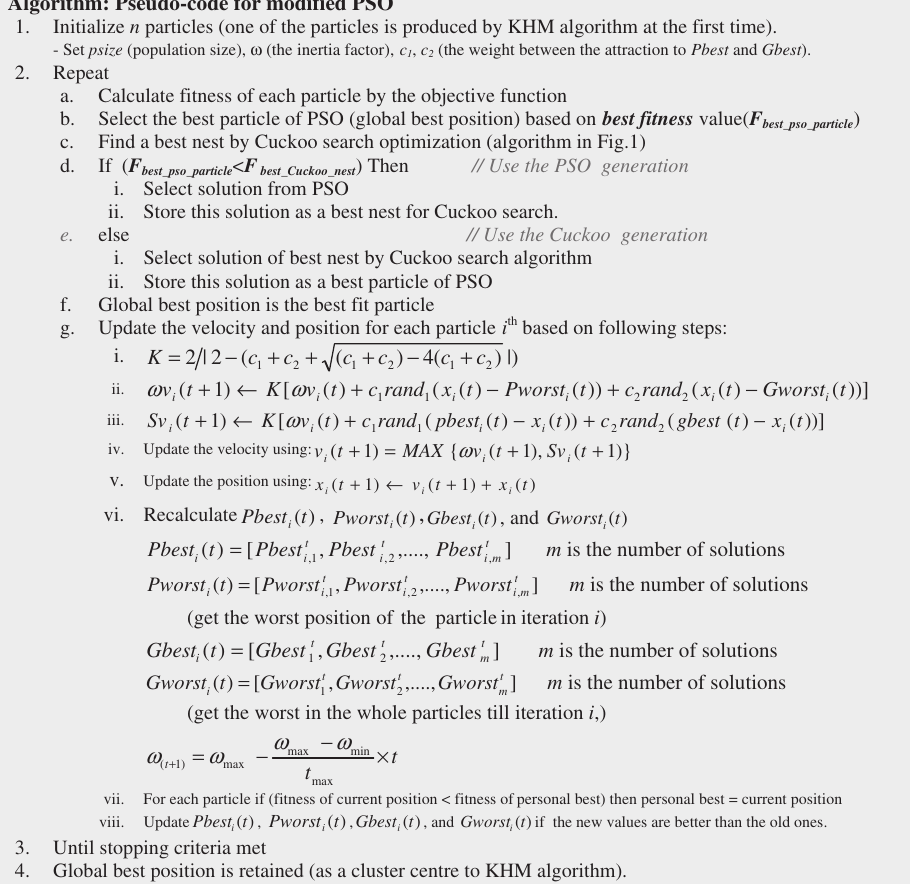
Algorithm: Pseudo-code for modified PSO 1. Initialize n particles (one of the particles is produced by KHM algorithm at the first time). - Set psize (population size), ω (the inertia factor), c 1 , c 2 (the weight between the attraction to Pbest and Gbest ). 2. Repeat